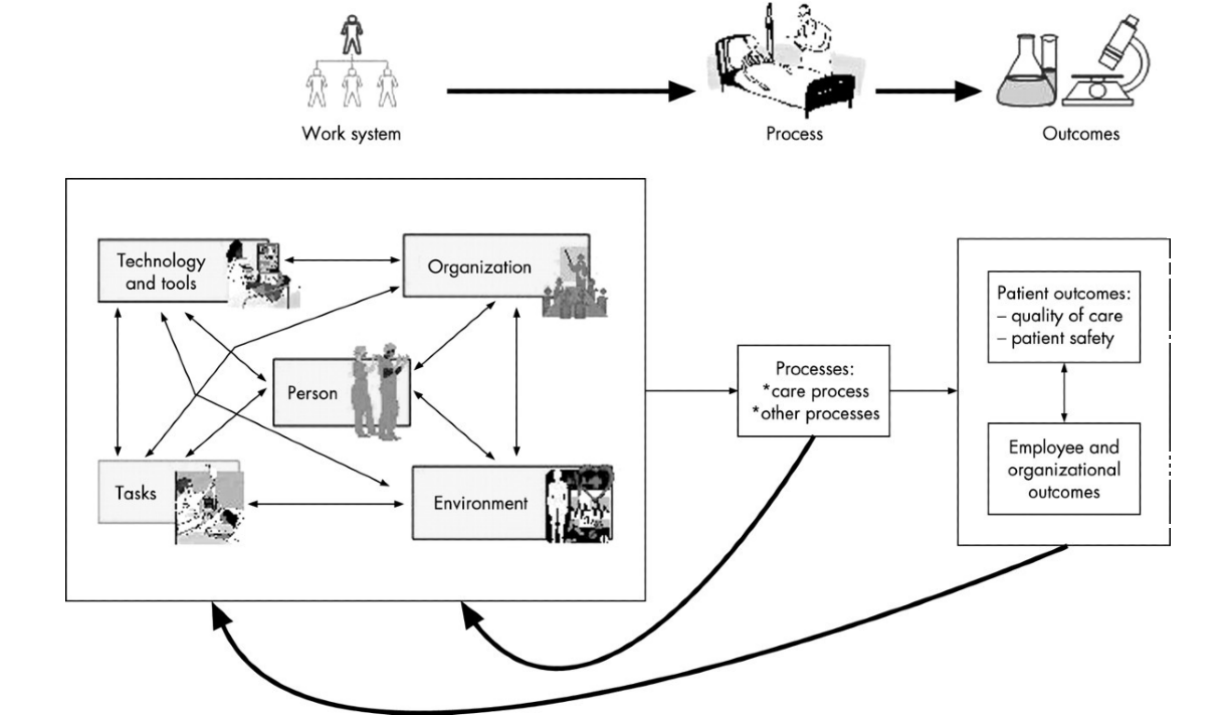
Figure 1. Systems Engineering Initiative for Patient Safety model of work system and patient